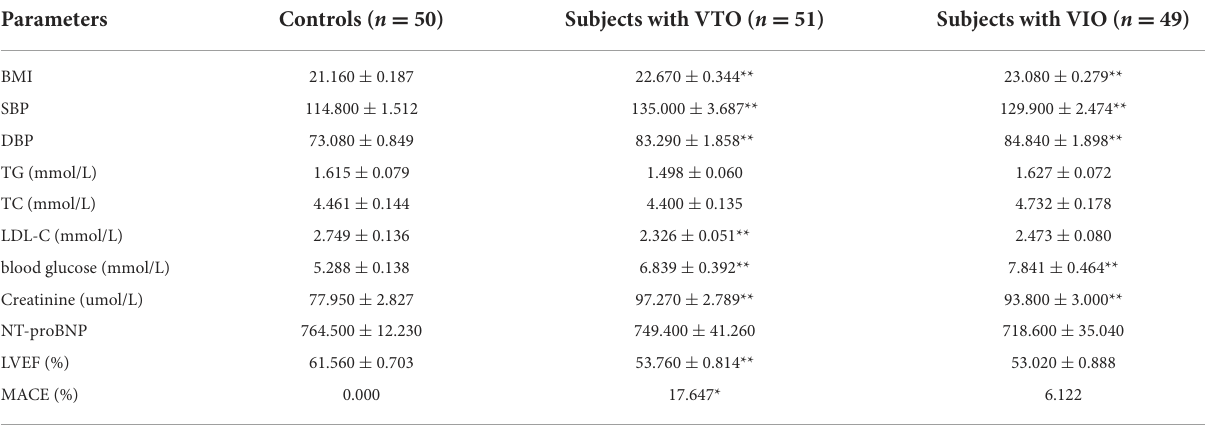
TABLE 2 Baseline clinical characteristics of the study subjects.